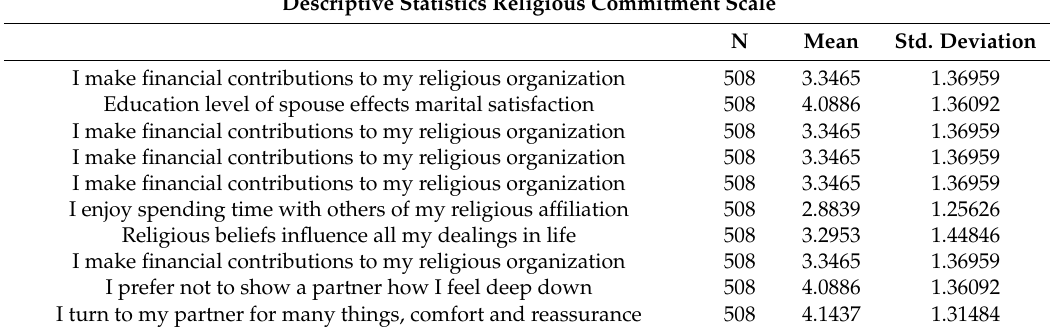
Table 4. Descriptive Statistics of Variables.